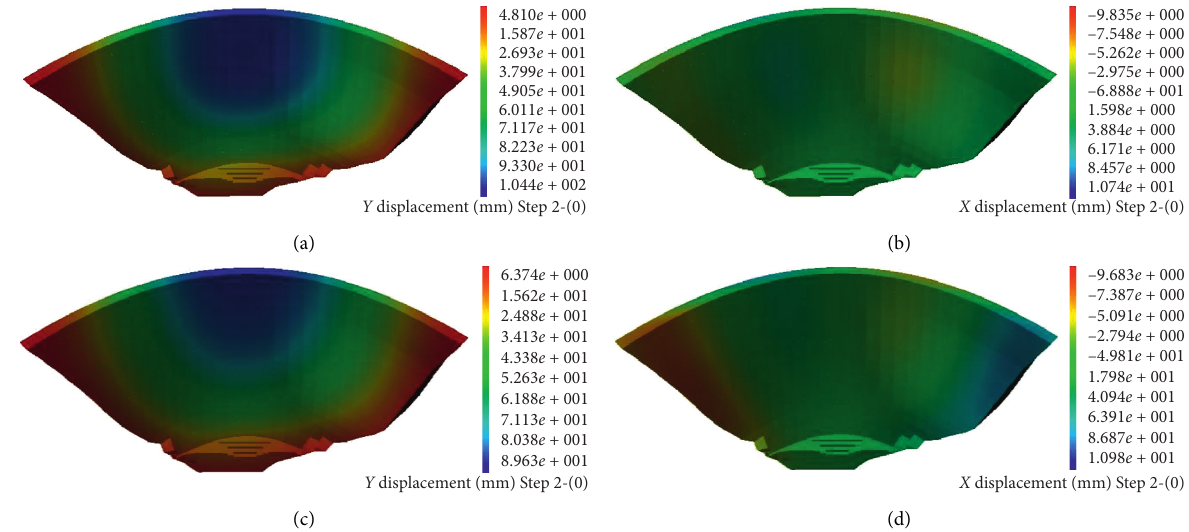
Figure 8: Comparison of the displacement distribution of the Xiluodu arch dam under conditions 4 and 5. Stress analysis of dam body. (a) Downstream river direction (condition 4). (b) Downstream transverse direction (condition 4). (c) Downstream river direction (condition 5). (d) Downstream transverse direction (condition